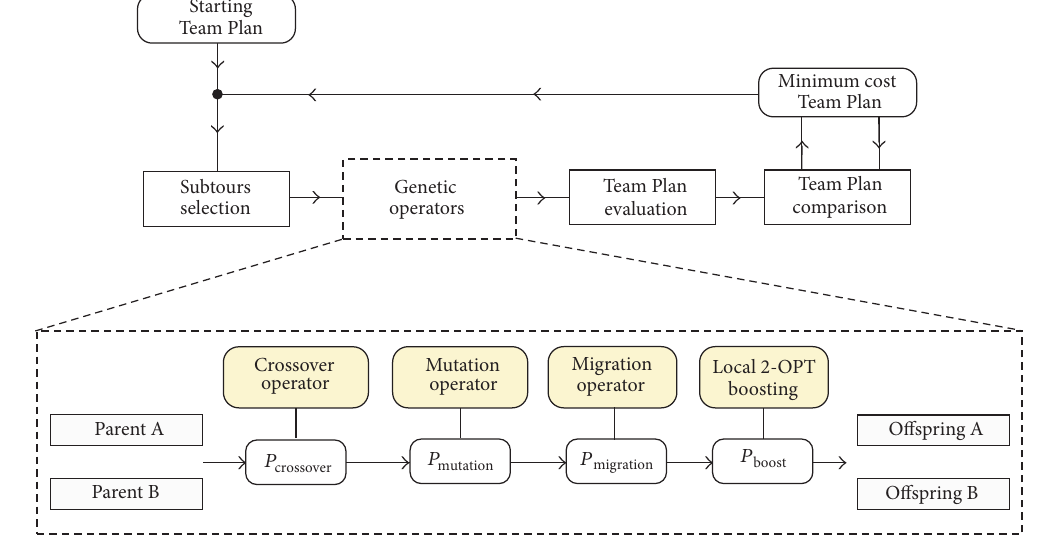
Figure 1: Flowchart of the evolution phase, together with the sequence of operators.